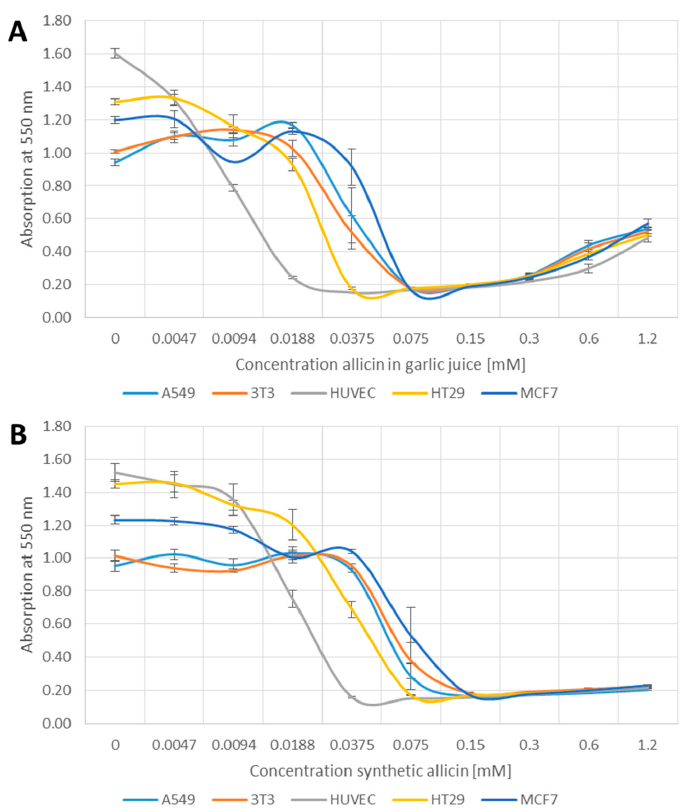
Figure 1. Effect of garlic juice normalized to its allicin concentration ( A ); and synthetic allicin ( B ) on the viability of different cell lines in the MTT (methylthiazoltetrazolium)-assay. All data points